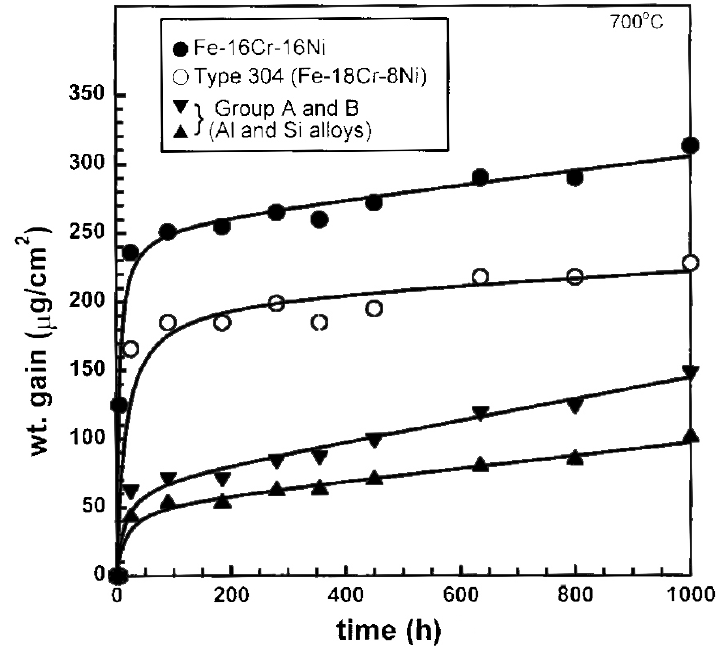
Figure 5. Oxidation behavior of Fe-16Cr-16Ni alloy in comparison with Type 304 alloy, alloys with Si + Al additions (Group A) and alloys with only Si additions (Group B) (adapted from [73] with permission of Springer).